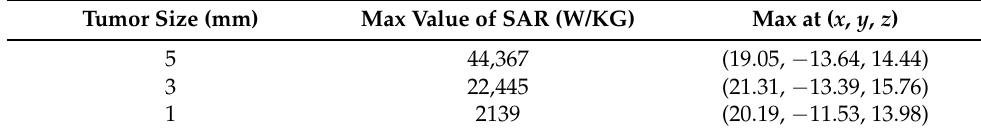
Table 2. Maximum value of SAR for different tumor sizes. Tumor Size